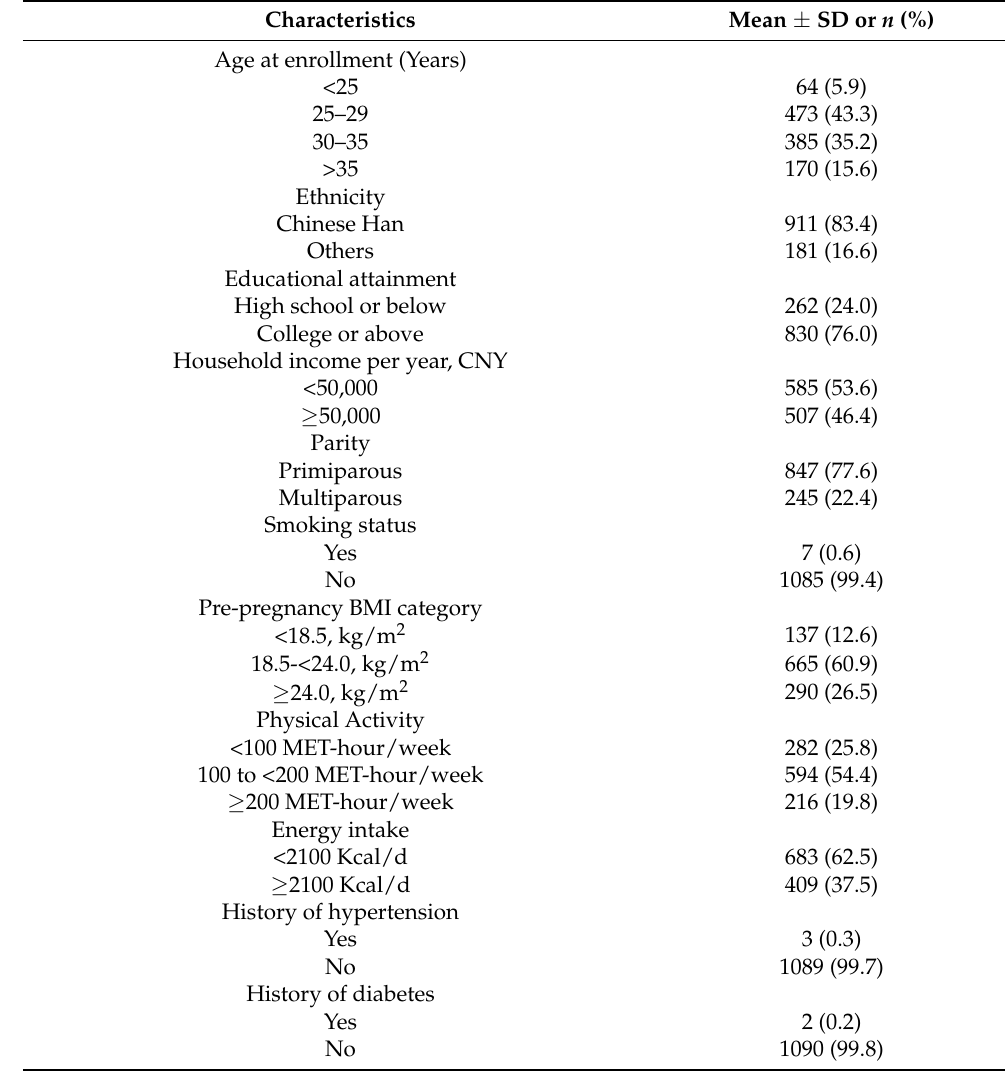
Table 1. Characteristics of pregnant women in the “Born in Shenyang” cohort study ( n = 1092).